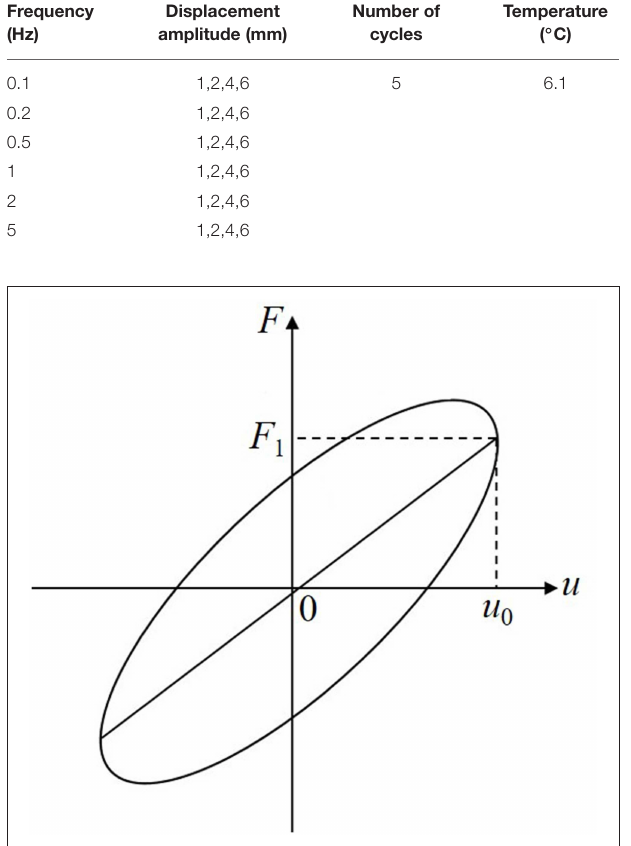
FIGURE 6 | Ideal force-displacement hysteretic curve of viscoelastic